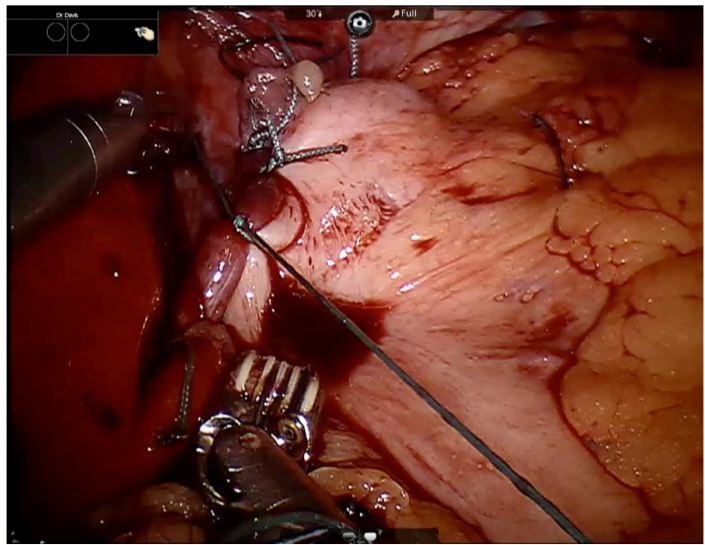
Figure 1. Dor fundoplication being performed